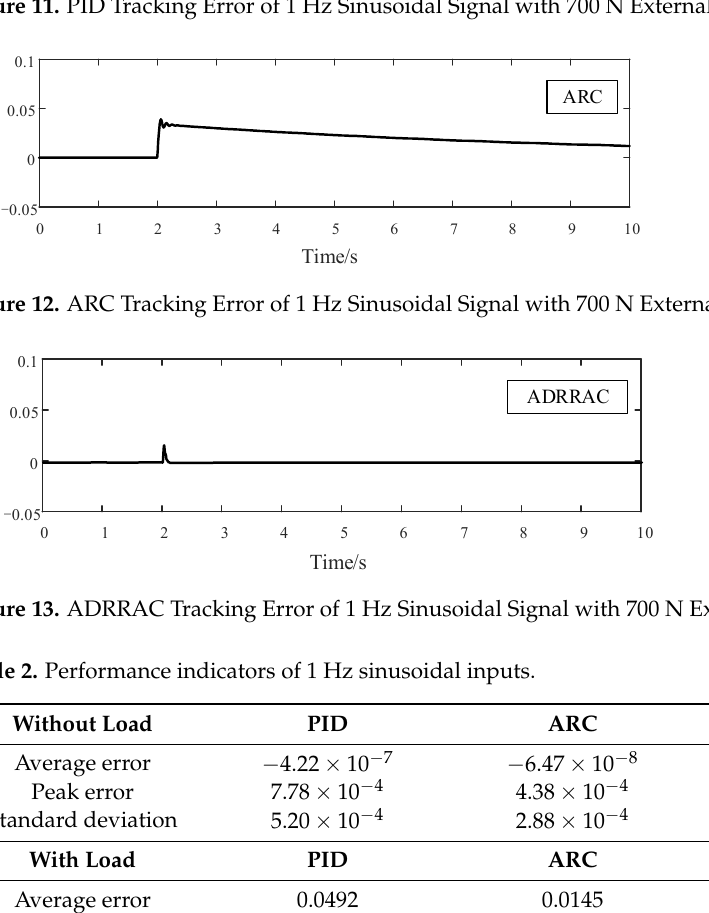
Figure 11. PID Tracking Error of 1 Hz Sinusoidal Signal with 700 N External Disturbance.